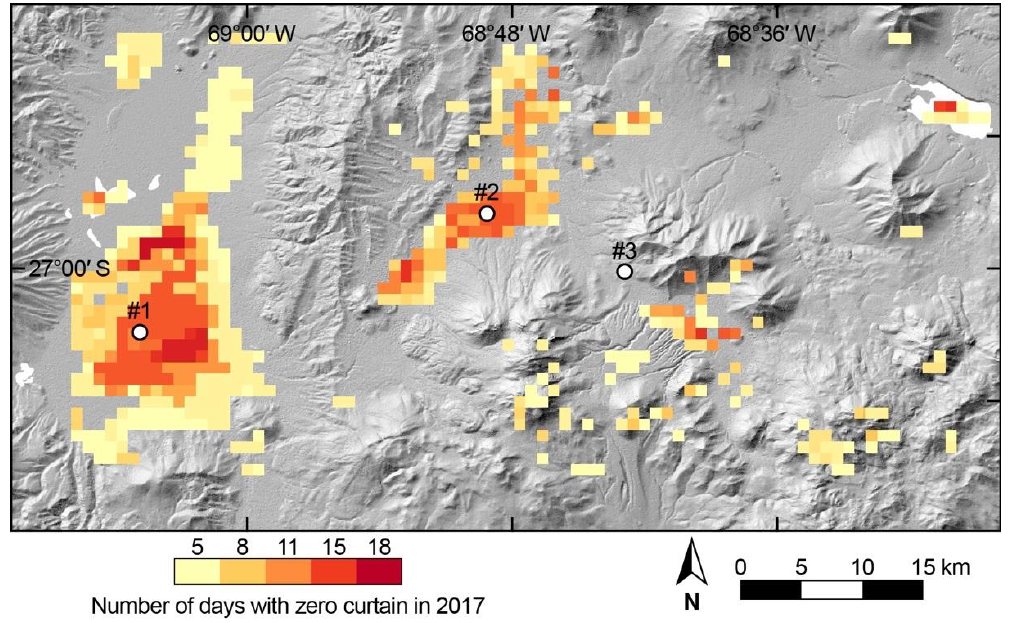
Figure 6. Number of days with zero curtains during the thaw season of 2017.